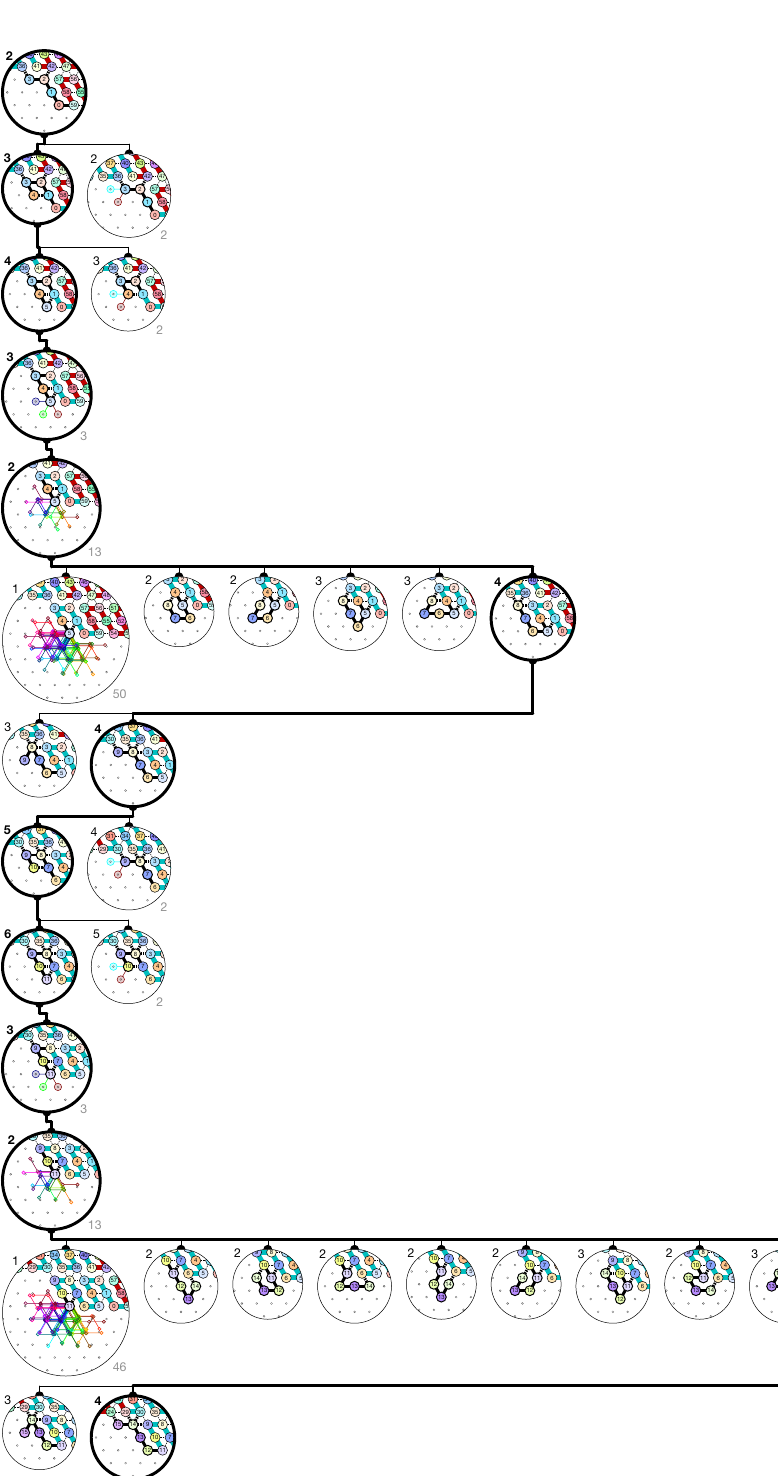
Figure 15. The folding certificate for the brick A11 in the environment: D2B2 C1